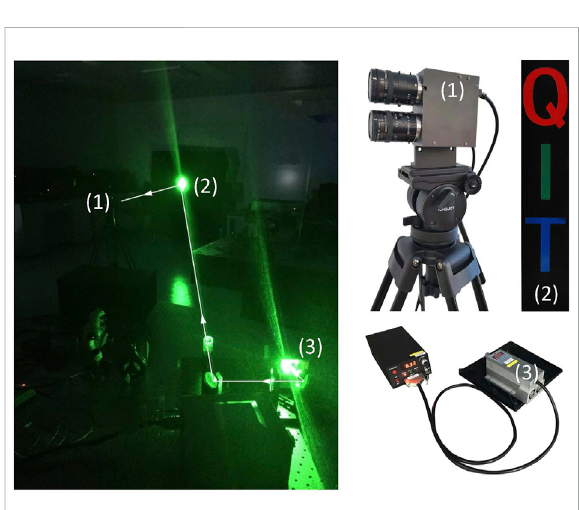
FIGURE 2 The left sub fi gure shows GISC spectral imaging experimental system based on active laser illumination, lights from the laser (3) pass through a re fl ector and an expander to illuminate the